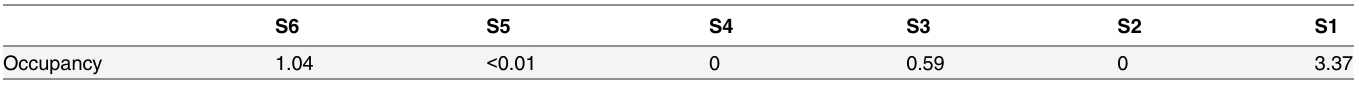
Table 3. Hydrogen bonding between thrombin and the bound peptide. In addition to P1-S1 interactions, also P6-S6 interactions rely on hydrogen bond- ing. The relatively specific S2 pocket does not show any hydrogen bonding at